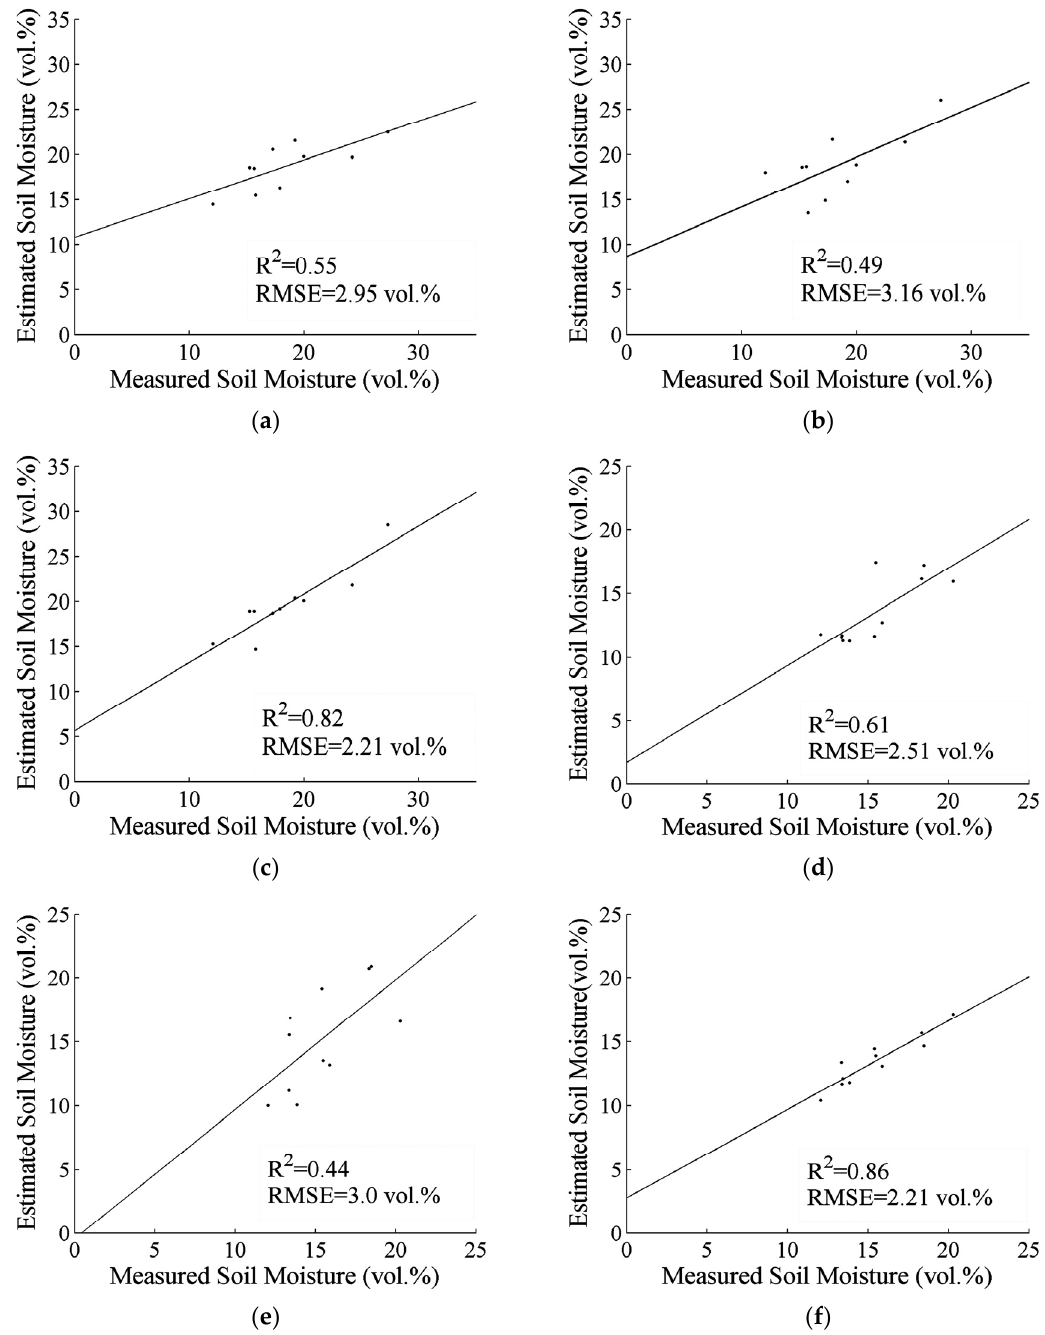
Figure 2. Comparisons between the measured and estimated soil moisture content using the SVR model: ( a ) Jiulong data set with TerraSAR-X ( R 2 = 0.55, RMSE = 2.95 vol%); ( b ) Jiulong data set with Radarsat-2 ( R 2 = 0.49, RMSE = 3.16 vol%); ( c ) Jiulong data set with TerraSAR-X and Radarsat-2 ( R 2 = 0.82, RMSE = 2.21 vol%); ( d ) Wannian data set with TerraSAR-X ( R 2 = 0.61, RMSE = 2.51 vol%); ( e ) Wannian data set with Radarsat-2 ( R 2 = 0.44, RMSE = 3.0 vol%); and ( f ) Wannian data set with TerraSAR-X and Radarsat-2 ( R 2 = 0.86, RMSE = 2.21 vol%). Quantitative evaluation between the estimated and measured soil moisture were implemented. The Root Mean Square Error (RMSE), determination coefficient ( R 2 ), Mean Relative Error (MRE), and Standard Deviation (SD) were selected as the indicators. The statistical results are shown in Table 2.